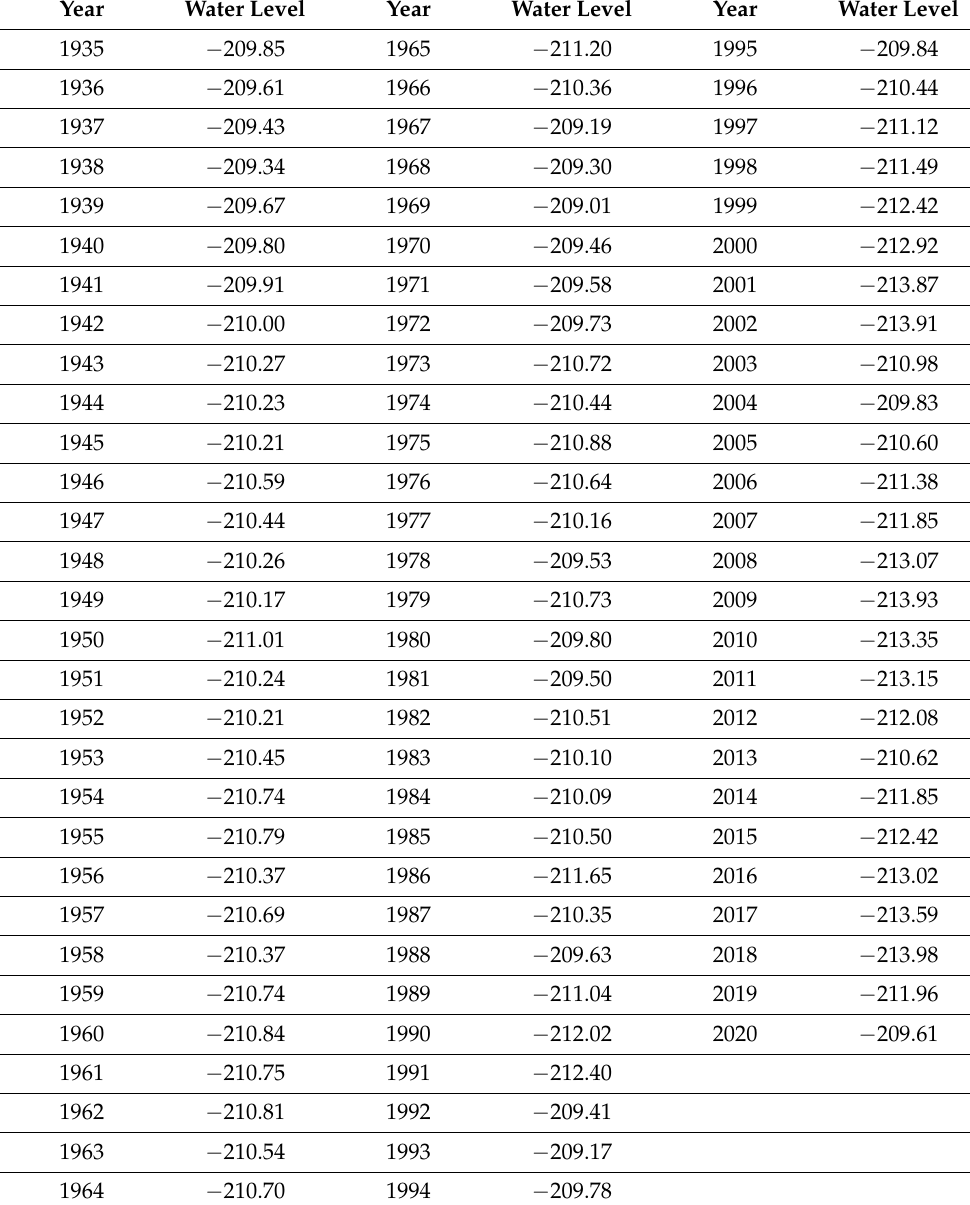
Table A4. Yearly data of the Kinneret water levels (m a.s.l.) from 1935 to